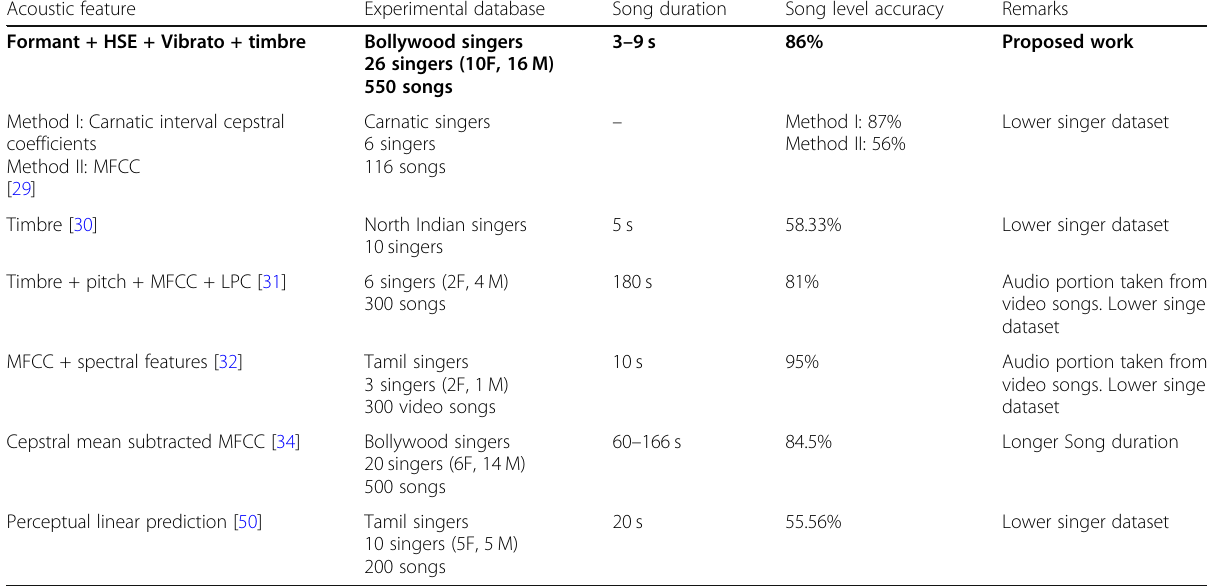
Table 6 Performance comparison of the proposed system ( F female singers, M male singers)